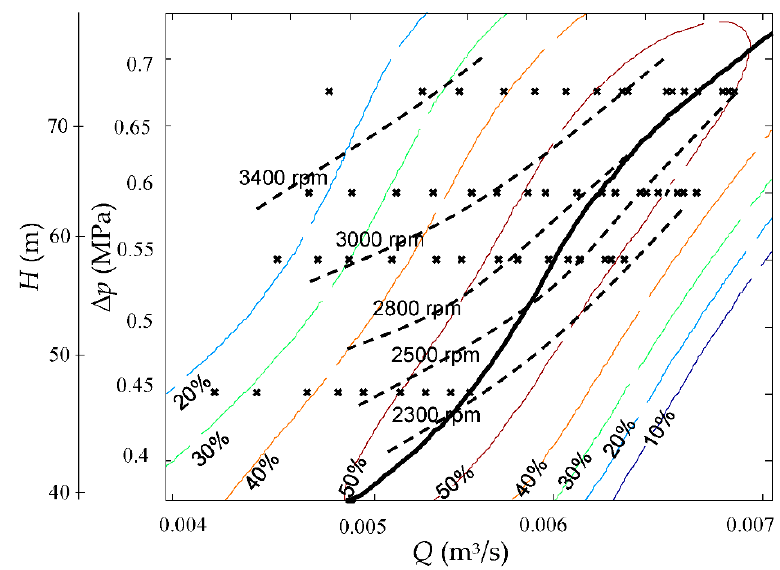
Figure 11. Speed regulation characteristics of ERPR in reduced pressure–flow-rate domain with isolines of constant efficiency.